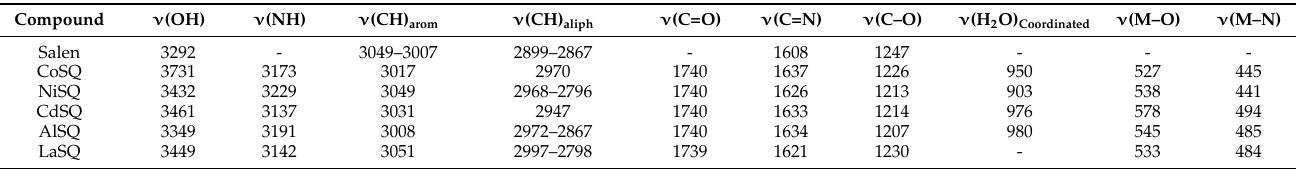
Figure 2. FT-IR spectral of salen Schiff base ligand (S) and its metal complexes (LaS, LaSQ) in 4000–400 cm − 1 . Table 3. FTIR spectral data in cm − 1 for salen and mixed-ligand salen/8-hydroxyquinoline metal complexes with Co(II), Ni(II), Cd(II), Al(III), and La(III).